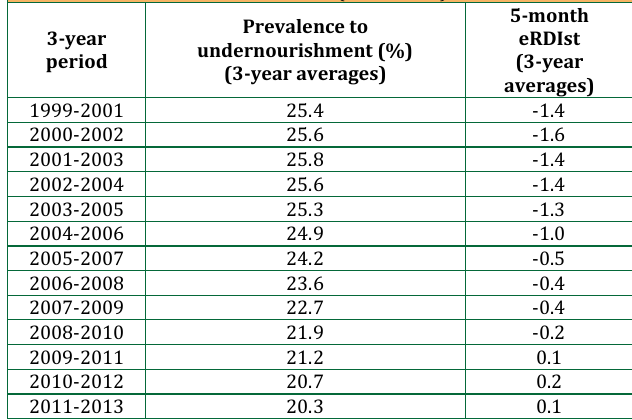
Figure 8: Plot of 3-year averages of Prevalence to undernourishment (%) against 3-year averages of the 5-month eRDI st showing a strong direct relationship between the two variables with R 2 = 0.9306. Table 7: 3-year averages of Prevalence to undernourishment (%) & 5-month eRDIst,